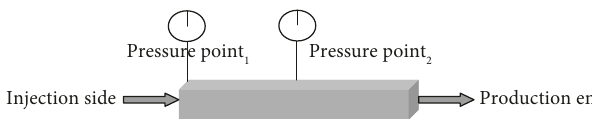
Figure 2: Diagram of the core and the value installation position.